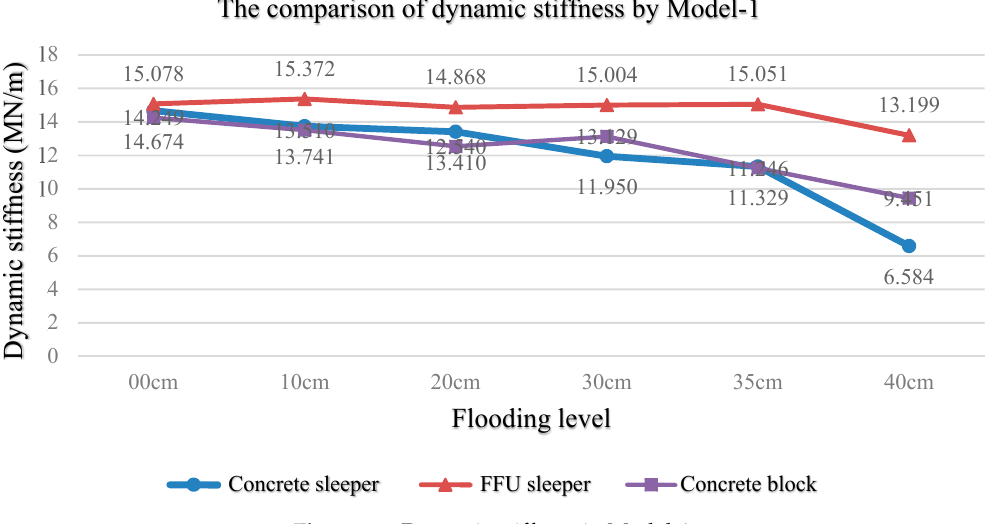
Figure 16. Dynamic stiffness in Model-1.